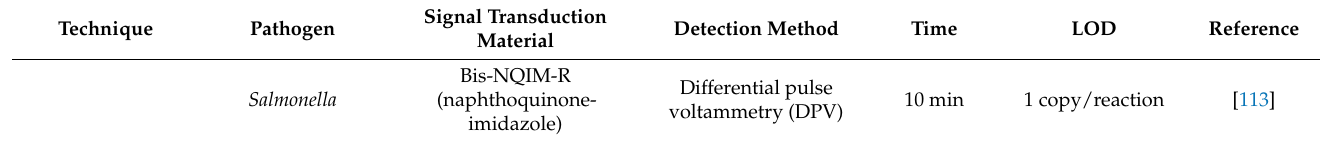
Table 2. LAMP-based real-time detection